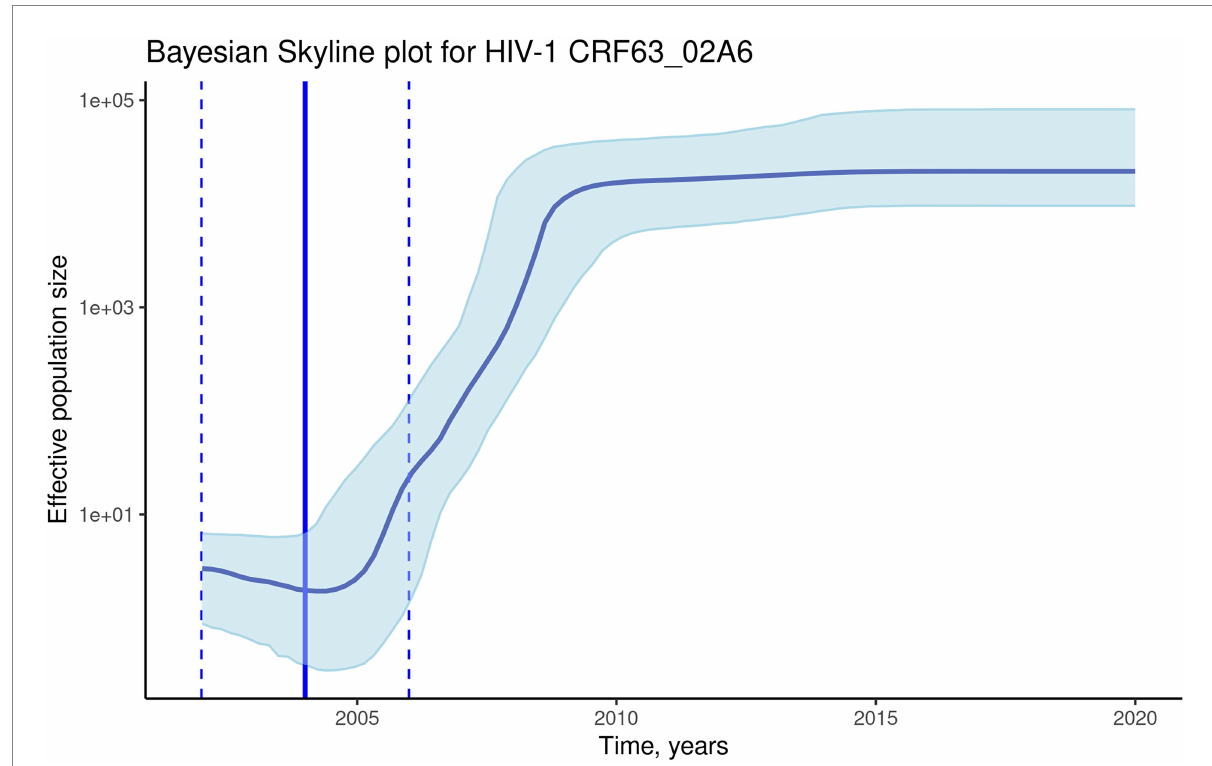
FIGURE 4 The Bayesian skyline plot of the 510 CRF63_02A6 pol gene sequences. The solid blue line indicates the median effective population size through time; the shaded blue area indicates the 95% highest posterior density (HPD) interval of the effective population size. The vertical solid black line indicates the median (2004) estimated tMRCA of the HIV-1 CRF63_02A6; the vertical dashed lines indicate the estimated tMRCA 95% HPD interval